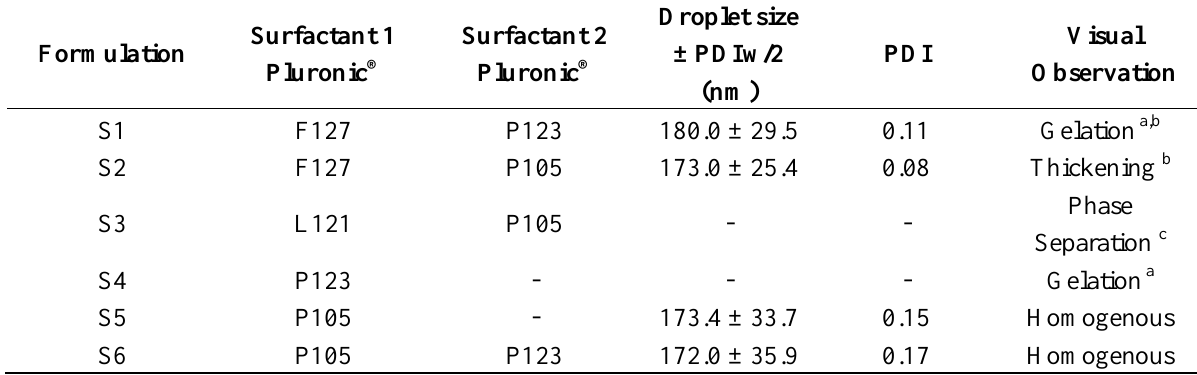
Table 1. Summary of formulations prepared with 10% w/v olive oil and 3% w/v surfactant system. Where two surfactants are used, they were at 1:1 w/w